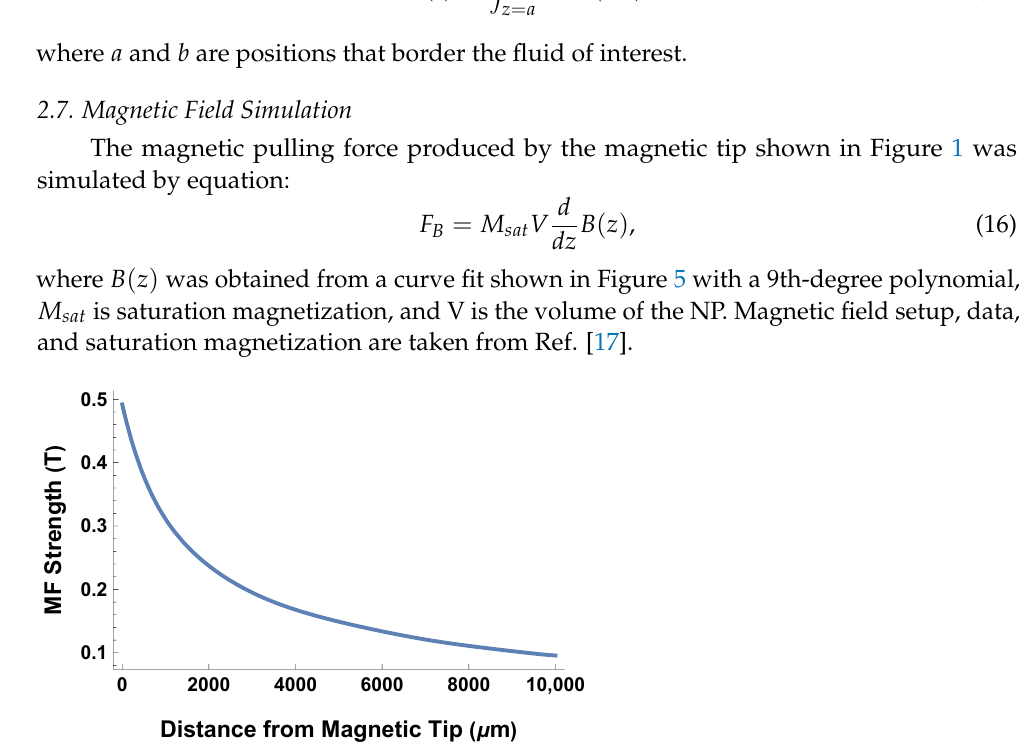
Figure 5. Magnetic field (MF) strength as a function of distance from the magnetic tip, i.e., position z . Data points were fitted with Mathematica using the fit command. The equation of the curve is given by B ( z ) = 0.491 T − 2.99 ∗ 10 − 4 T